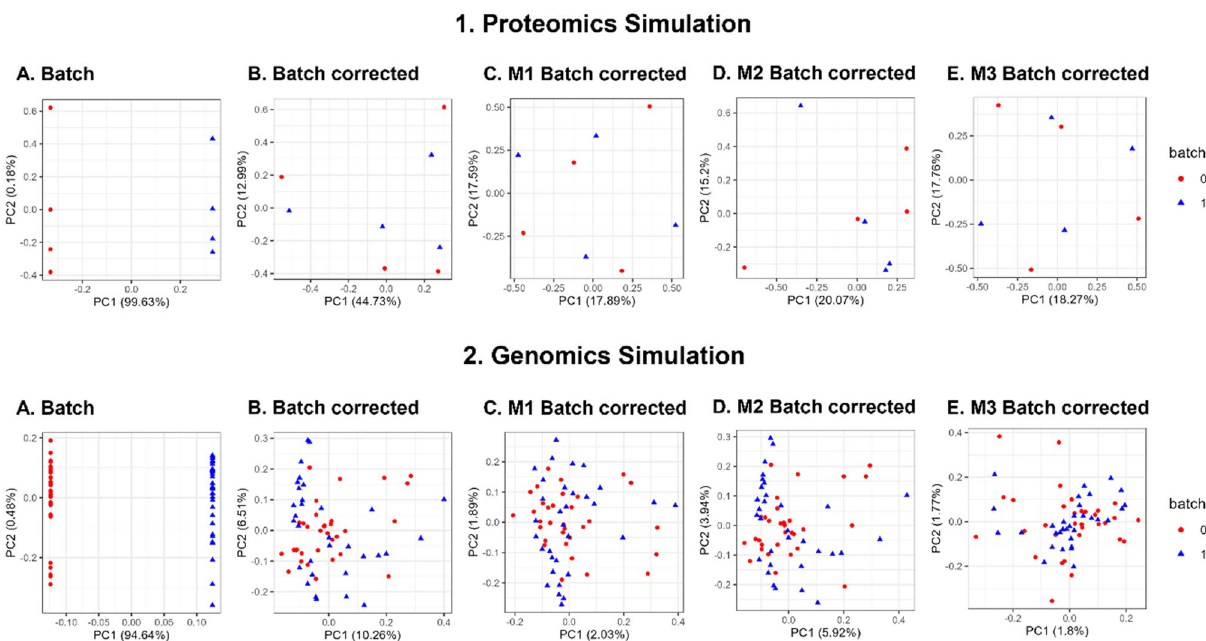
Figure 5. PCA Scatterplots for 1. Proteomics Simulation and 2. Genomics Simulation showed that despite reporting higher gPCA levels for M2, samples appear well-mixed, with no apparent batch effects for all imputation strategies (M1–M3), given the first two principal components (PC1 and PC2) (c.f. Figure S5 for full